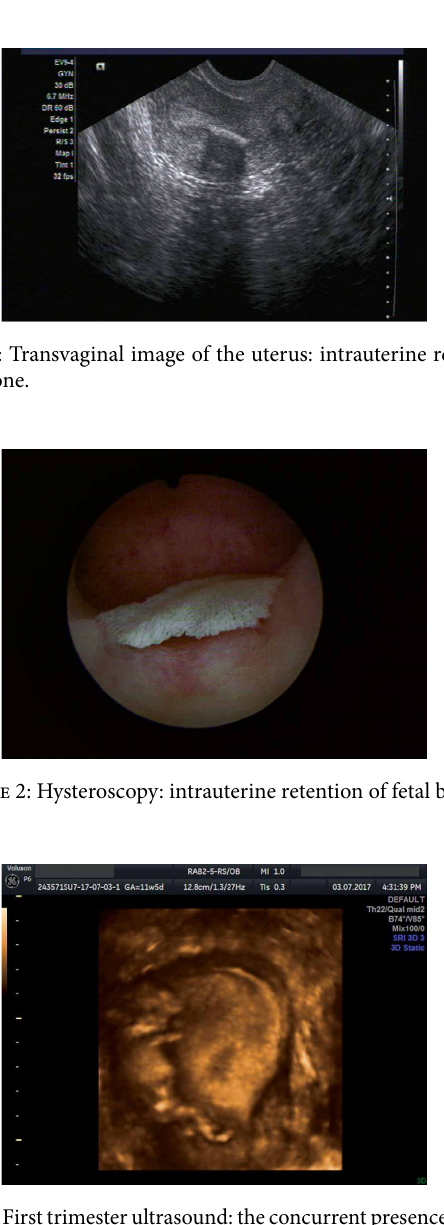
Figure 3: First trimester ultrasound: the concurrent presence of fetus and fetal bone.